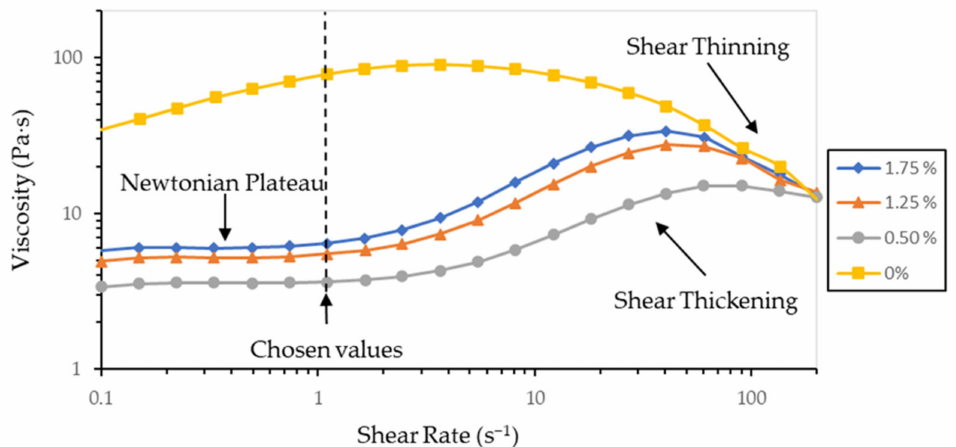
Figure 4. Viscosity curves for resin samples with 40 vol% alumina and different dispersant contents. It can be seen how the shear thickening and shear thinning behaviour shifts towards higher shear rates as it approaches to the optimum dispersant.